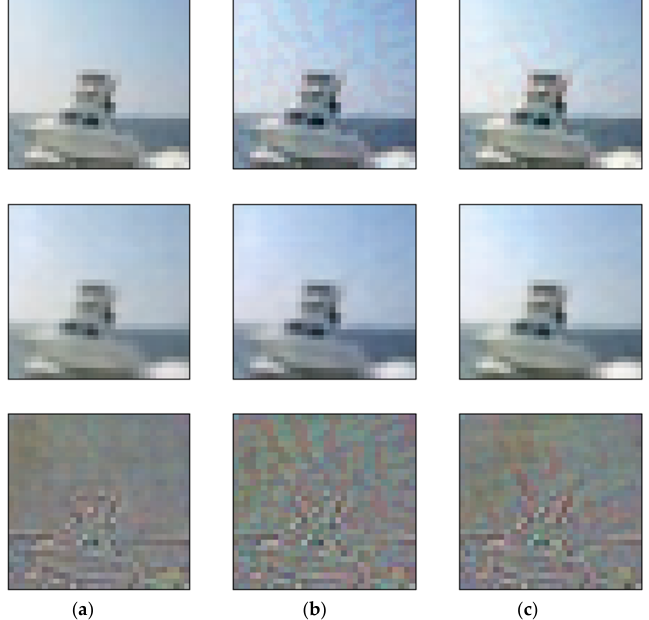
Figure 6. Effectiveness of Data Washing algorithm. First row: without Data Washing. Second row: with Data Washing. Third Row: enhanced Data Washing. ( a ) Without attack. ( b ) TensorClog. ( c ) Category Diverse.